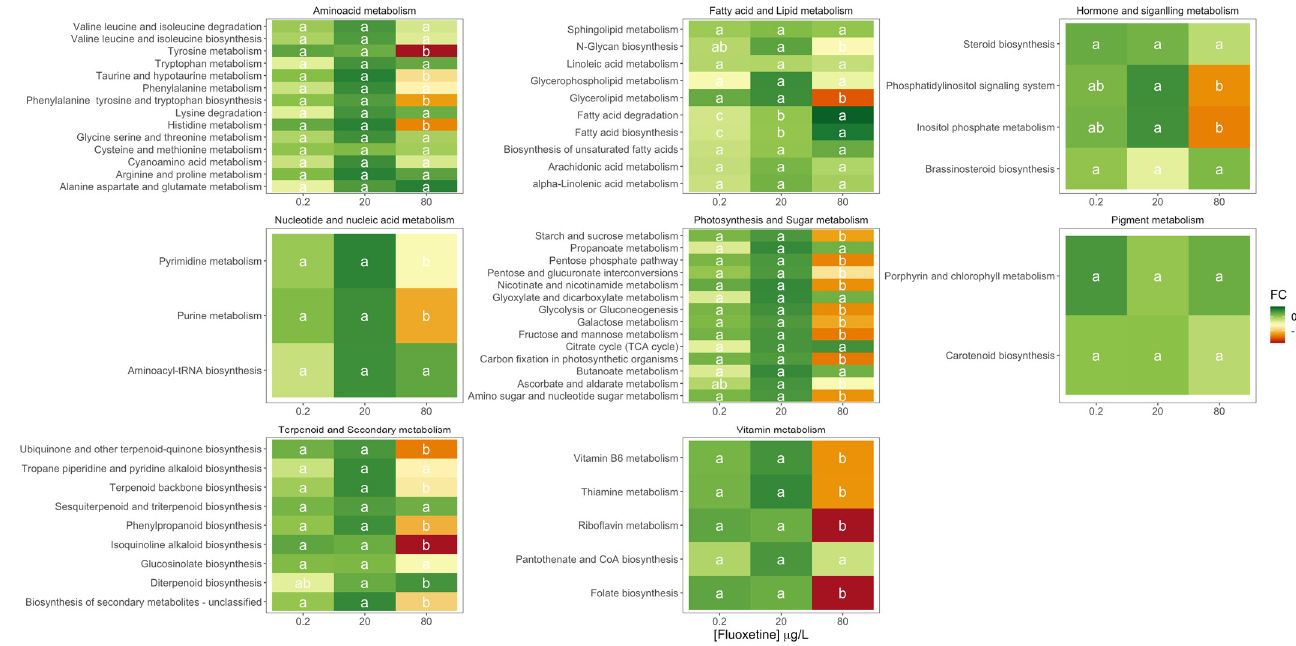
Figure 5. Fold-change heatmap of the different metabolic pathways of each metabolism group identified in the diatom cells exposed to 0.2, 20 and 80 µg/L fluoxetine ( n = 3, different letters denote significant differences at p < 0.05).